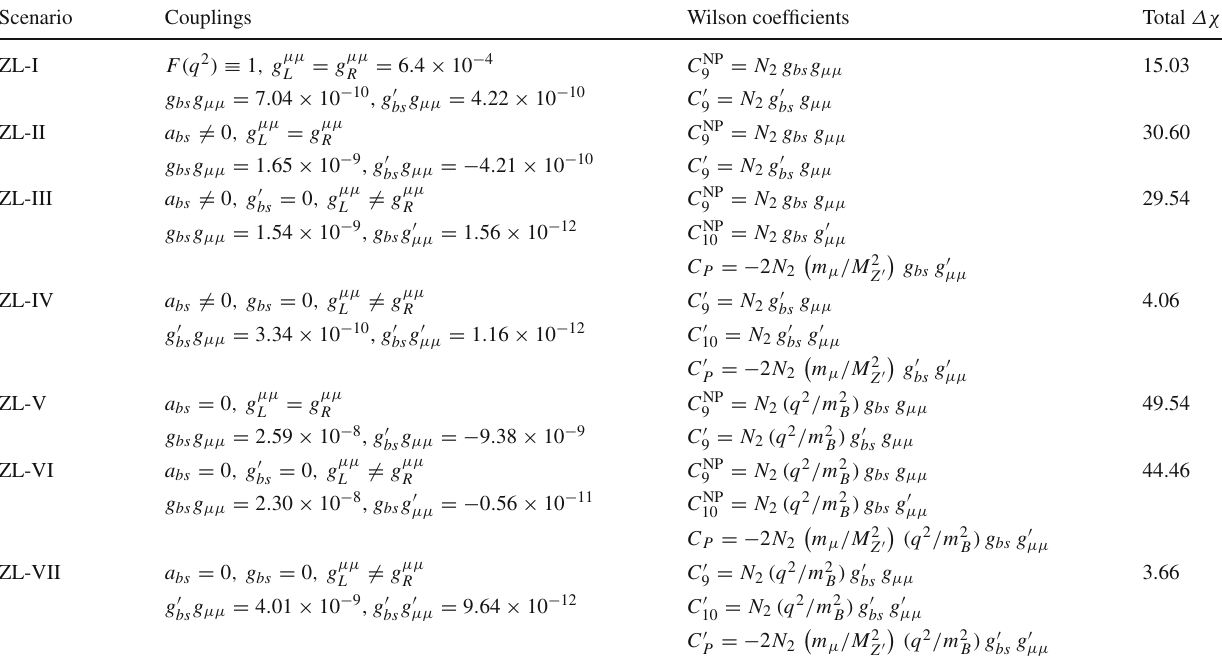
≡ g (cid:4) . The value of χ 2 is ≈ 197 bs bs SM